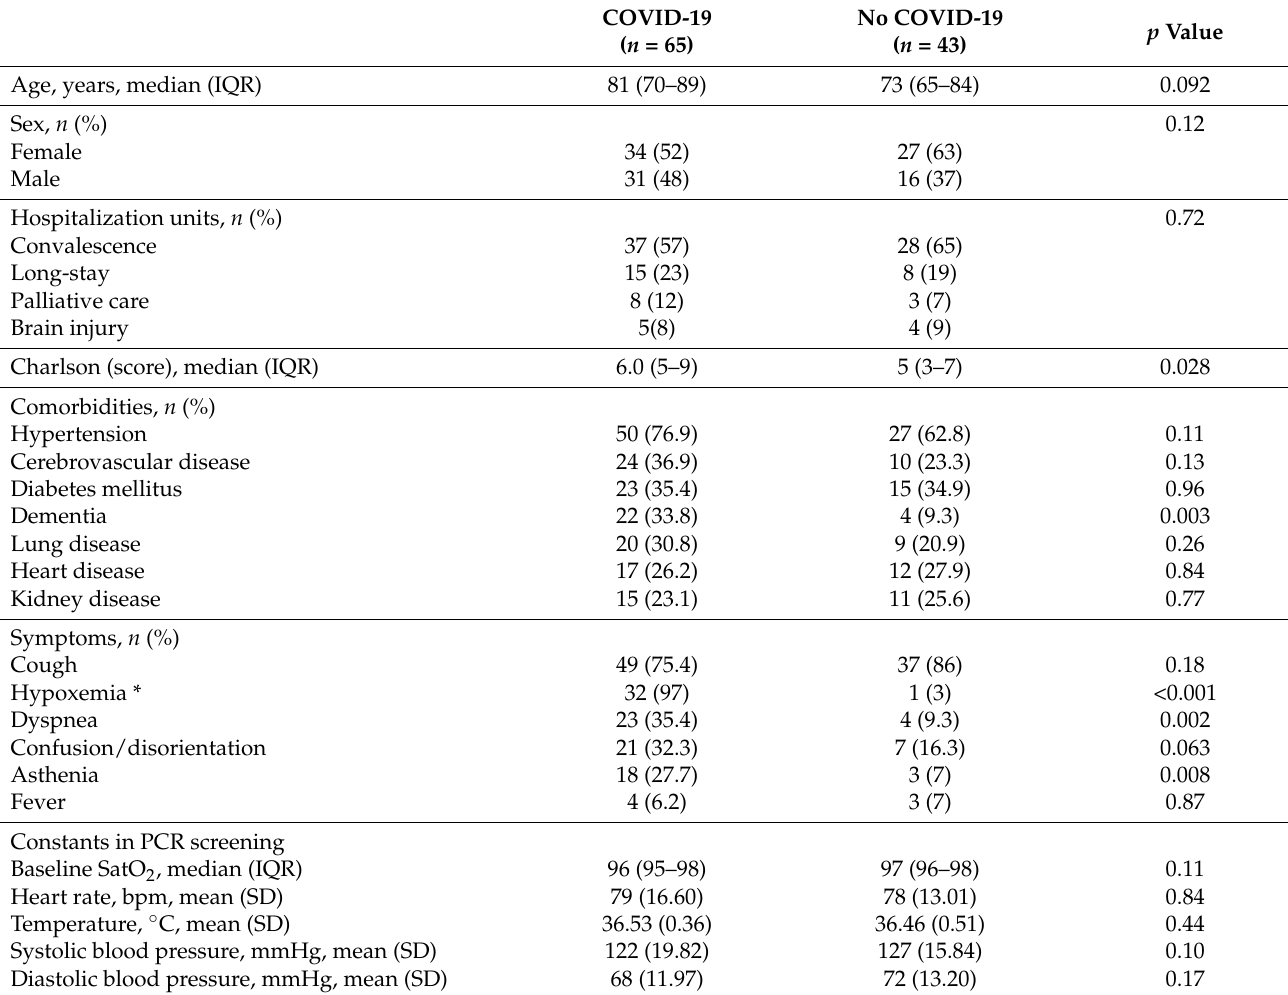
Table 1. Epidemiological and clinical differences in patients with and without nosocomial COVID-19.